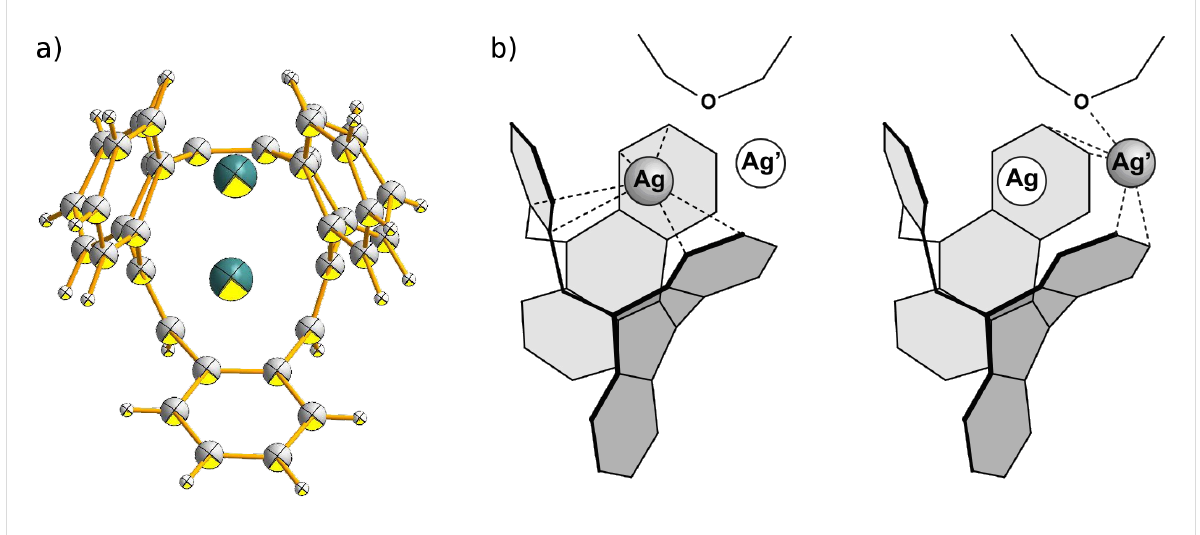
Figure 2: a) ORTEP drawing of the crystal structure of 4 . Ag + and Ag + , describe the two disordered positions of Ag + . For further perspective views see Supporting Information File 1. b) Simplified structural scheme for the coordination and disorder of the Ag + ion in the X-ray structure of complex 4 .